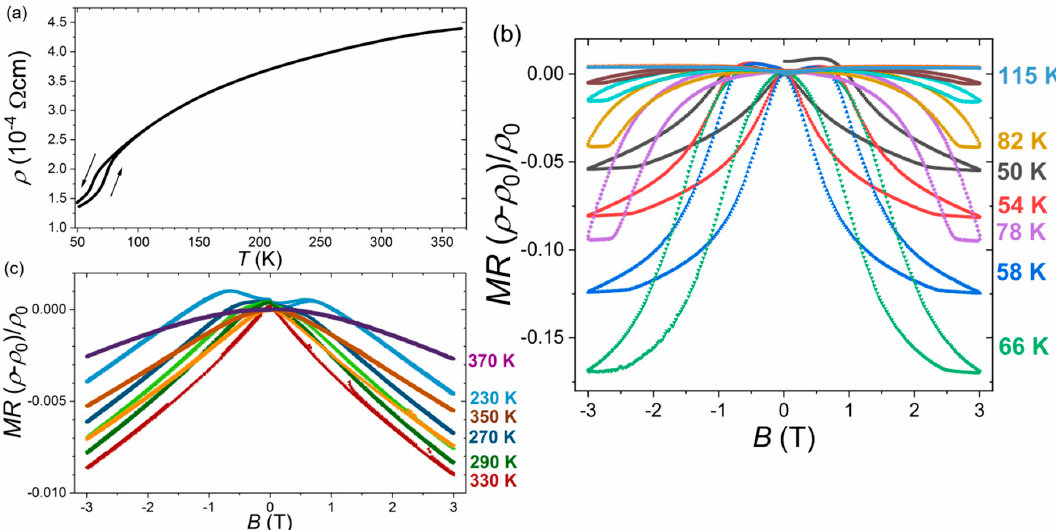
Figure 2. ( a ) Temperature dependence of the resistivity for Sc 0.28 Ti 0.72 Fe 2 in B = 2 T. Magnetoresistance at selected temperatures around T t1 ( b ) and T C ( c ).